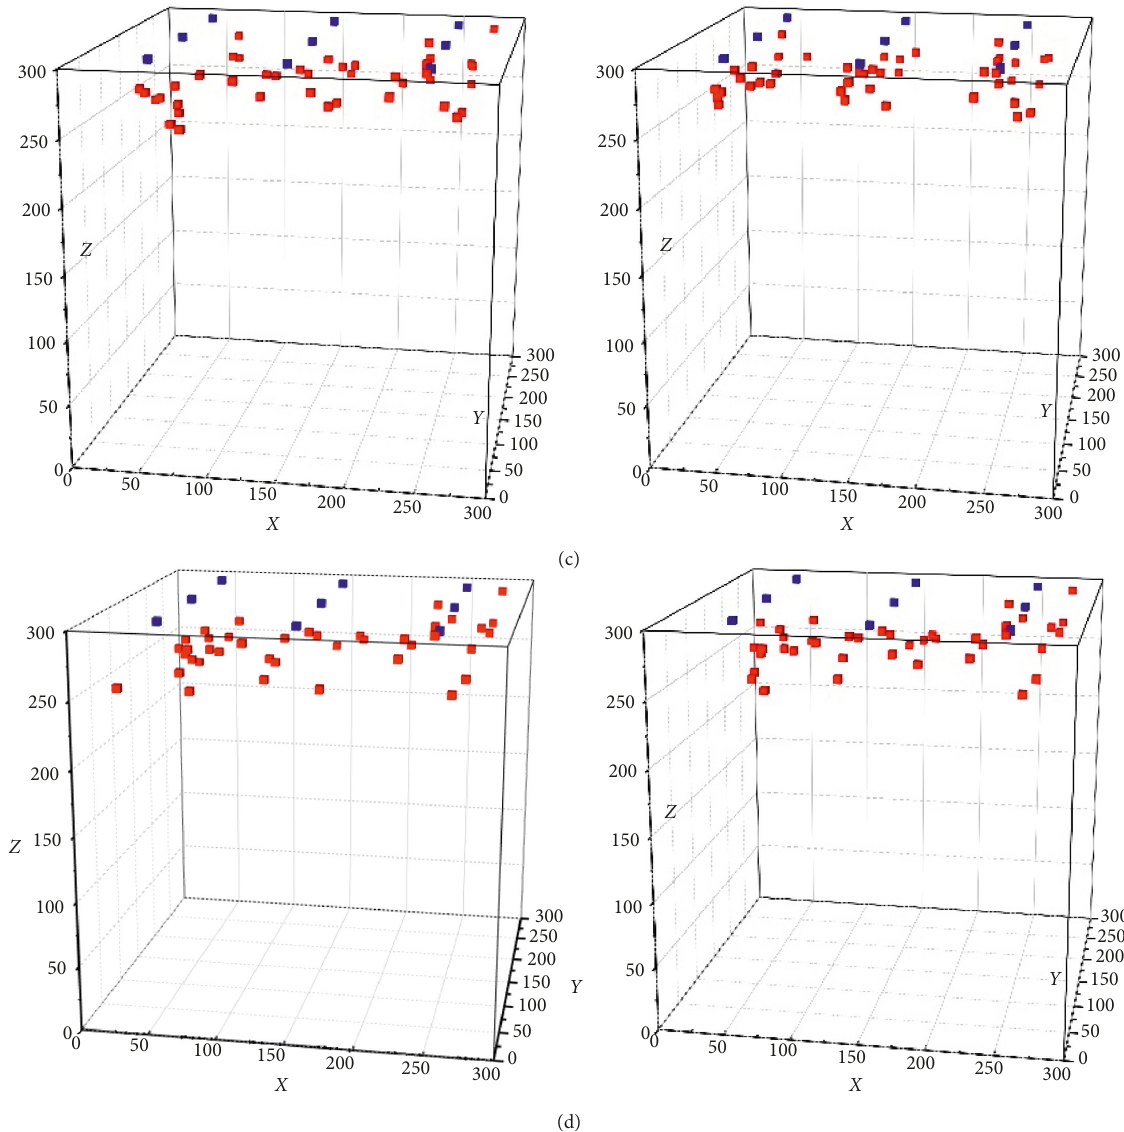
Figure 8: 3D localization results before (left) and after (right) the wave speed modification: (a) 1#; (b) 2#; (c) 3#; (d) 4# (blue points are break points, and red points are locating